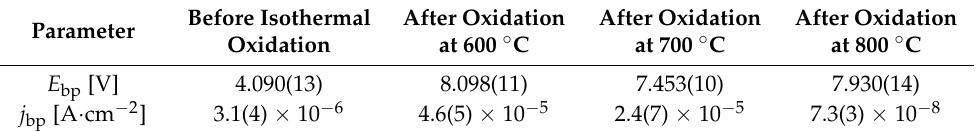
Table 5. Key potential-current parameters for the Ti-6Al-7Nb alloy before and after isothermal oxidation, determined based on the potentiodynamic measurements presented in Figure 9. Before Isothermal After Oxidation After Oxidation After Oxidation Parameter Oxidation at 600 ◦ C at 700 ◦ C at 800 ◦ C E bp